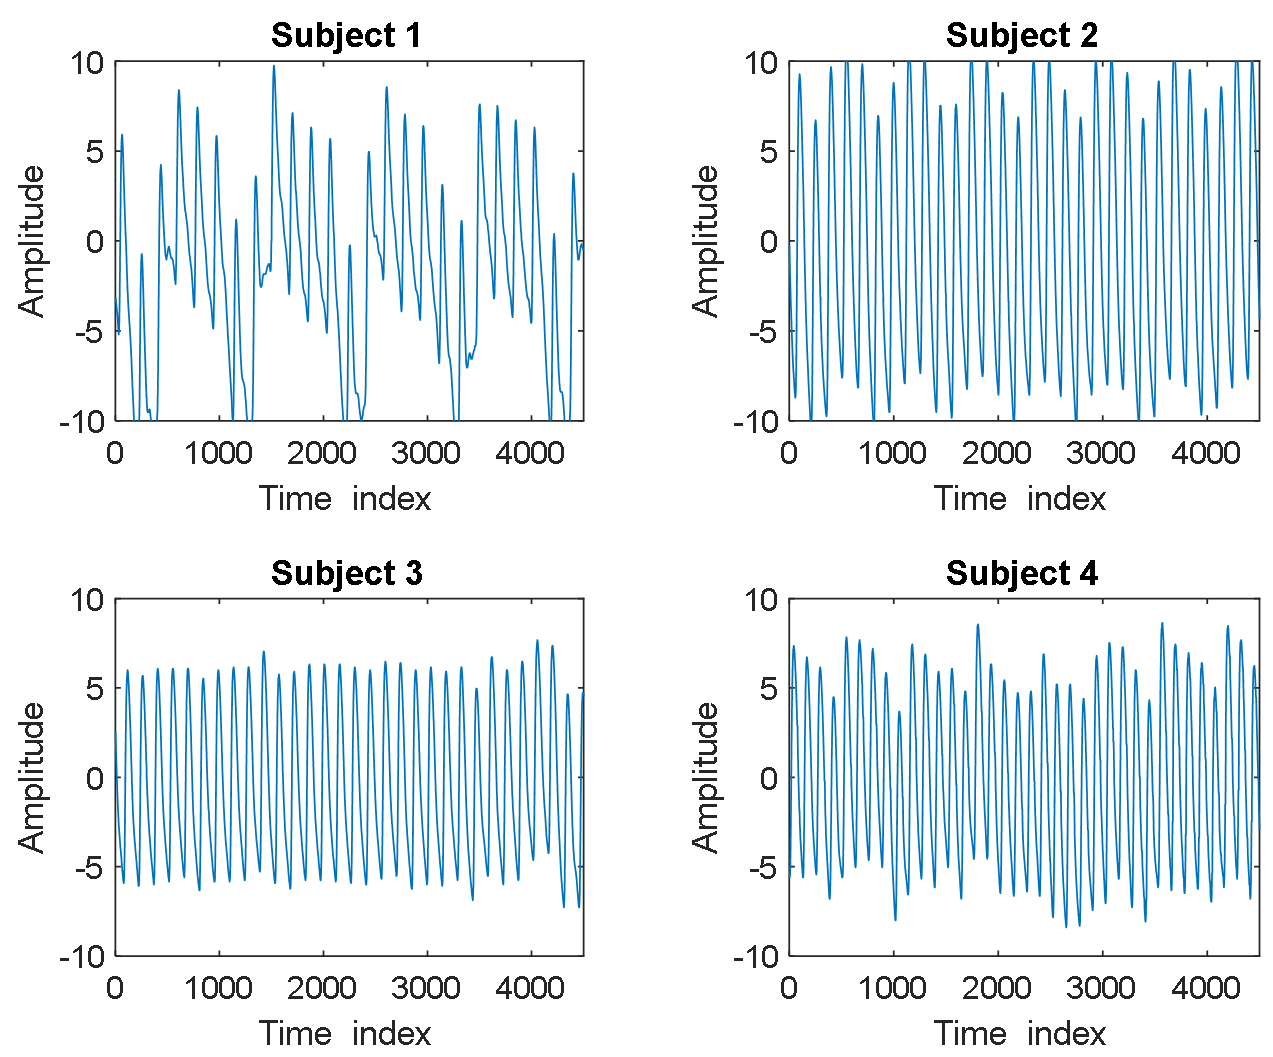
Figure 3. Samples of four different waveforms of 15-second PPG